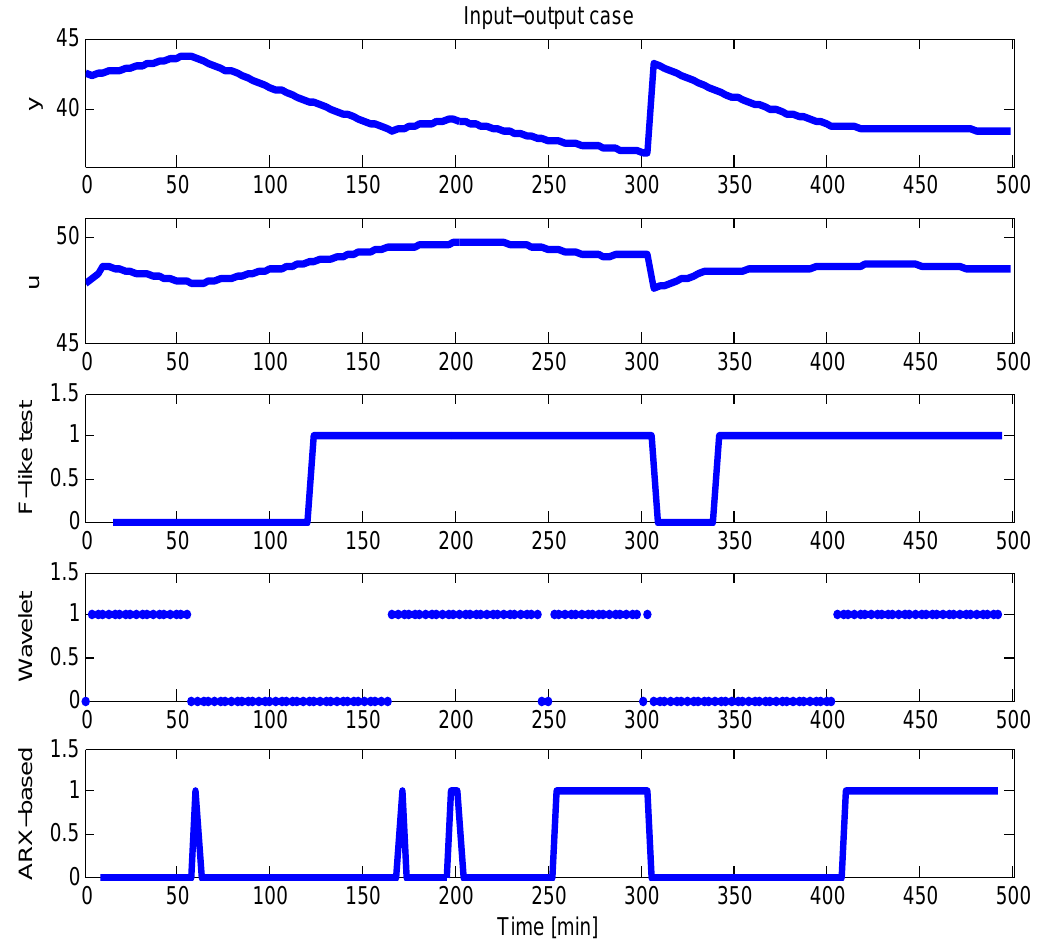
Figure 18. HX4 input-output case with a measurement frequency of 3